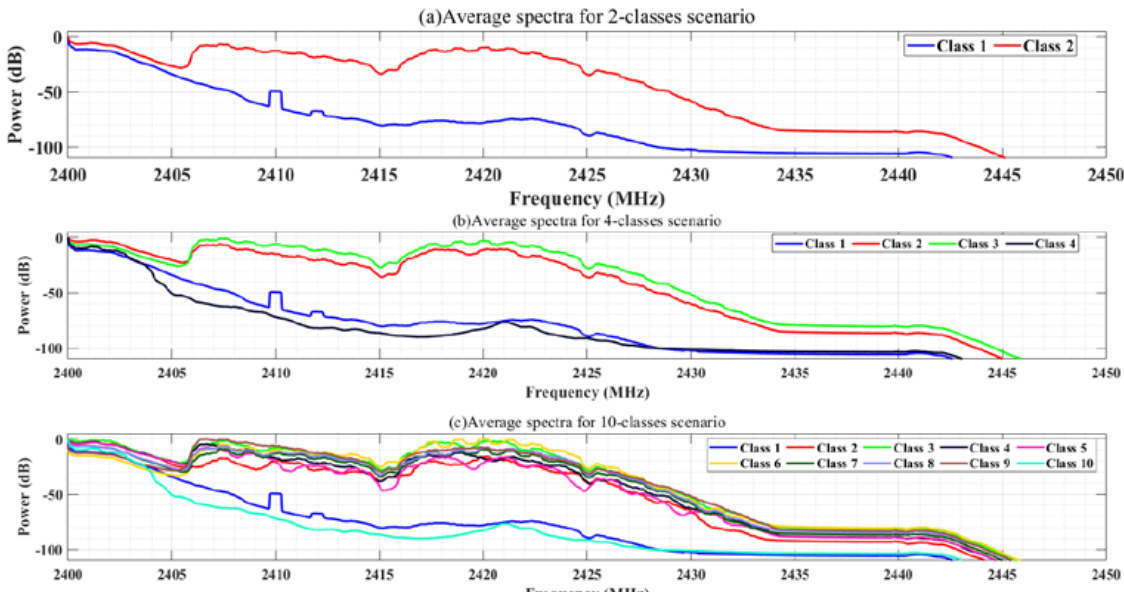
Figure 2. Average power spectrum of the RF activities for 2, 4, and 10 classes scenarios: In ( a ), class 1 is for RF background activities and class 2 is for the drones RF communications (to be supplied to the UAV Detection Network). In ( b ), class 1 is for RF background activities and classes 2–4 are for the Bebop, AR, and Phantom drones (to be supplied to the UAV Identification Network). In ( c ), class 1 is for RF background activities, classes 2–5 are for the Bebop 4 different flight modes, classes 6–9 are for the AR 4 different flight modes; and lastly, class 10 is for the Phantom single flight mode (to be supplied to the UAV Classification Network).